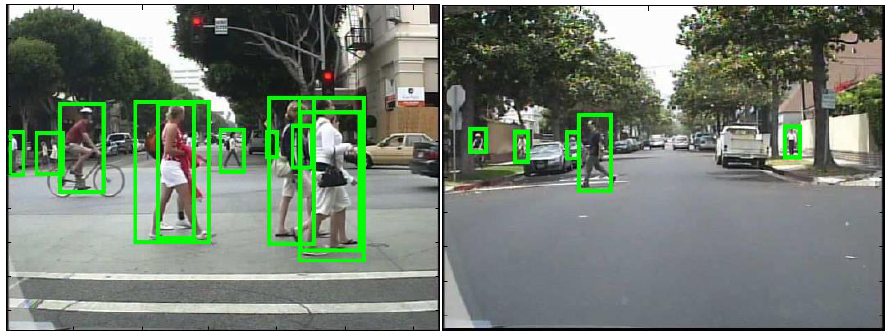
Figure 1. Example images and ground truth annotations in the Caltech pedestrian benchmark. Note that the resolutions of the pedestrians are in a wide